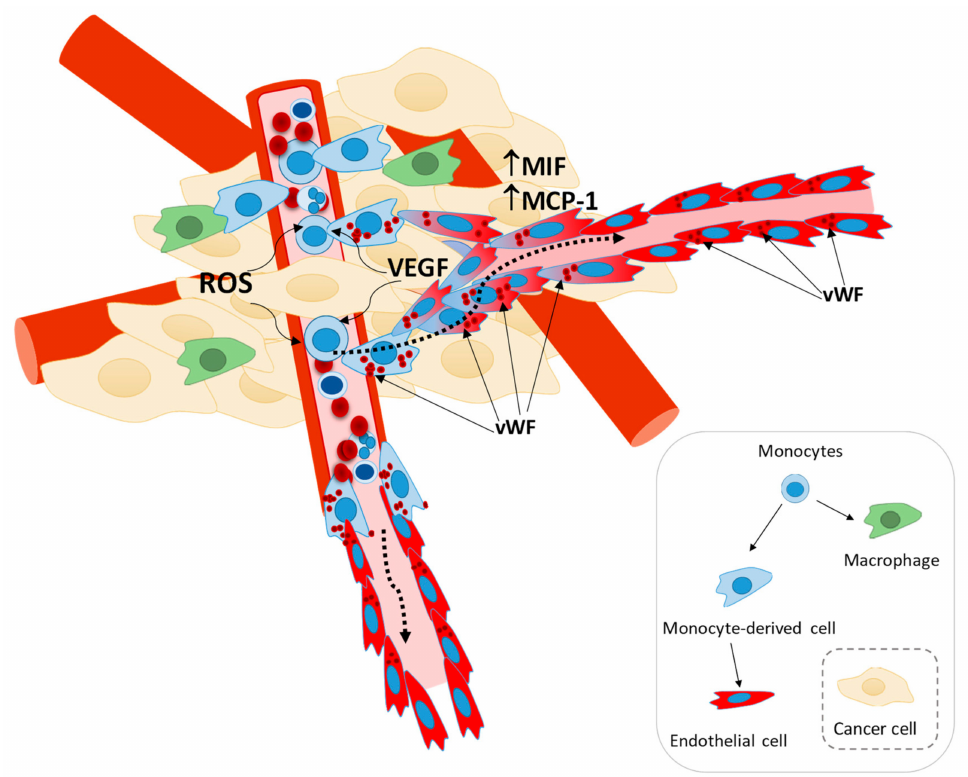
Figure 6. Monocytes recruitment into the tumor and endothelial di ff erentiation. Our working model demonstrate that monocytes could act as EPCs and be incorporated into neo-vasculature.